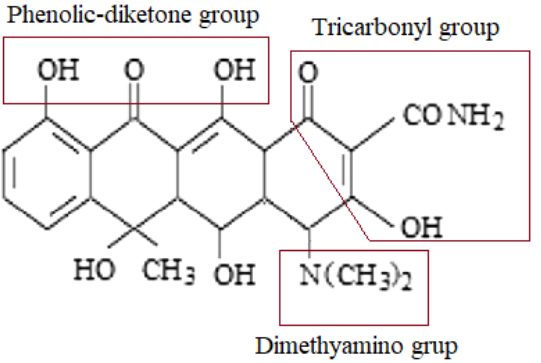
Figure 6. Oxytetracycline (OTC) molecular structure with marked dissociating groups [69]: tricarbonyl group pK a1 = 3.3; phenolic diketone group pK a2 = 7.68; dimethylamine group pK a3 − = 9.69.